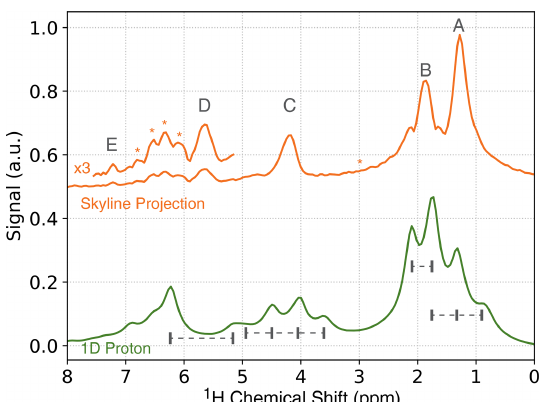
Figure 5. NMR spectra of ethyl crotonate. Top: skyline projection of 2D JRES experiment. The locations of strong-coupling artifacts are indicated by asterisks. Bottom: 1D 1 H NMR